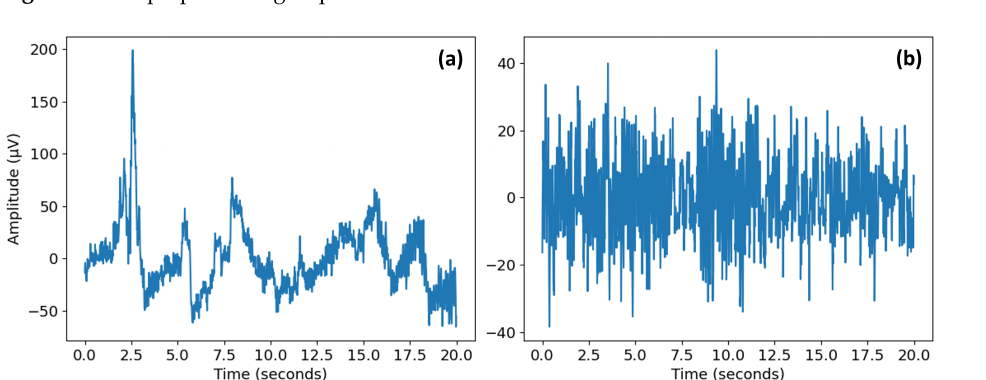
Figure 2. EEG preprocessing steps.